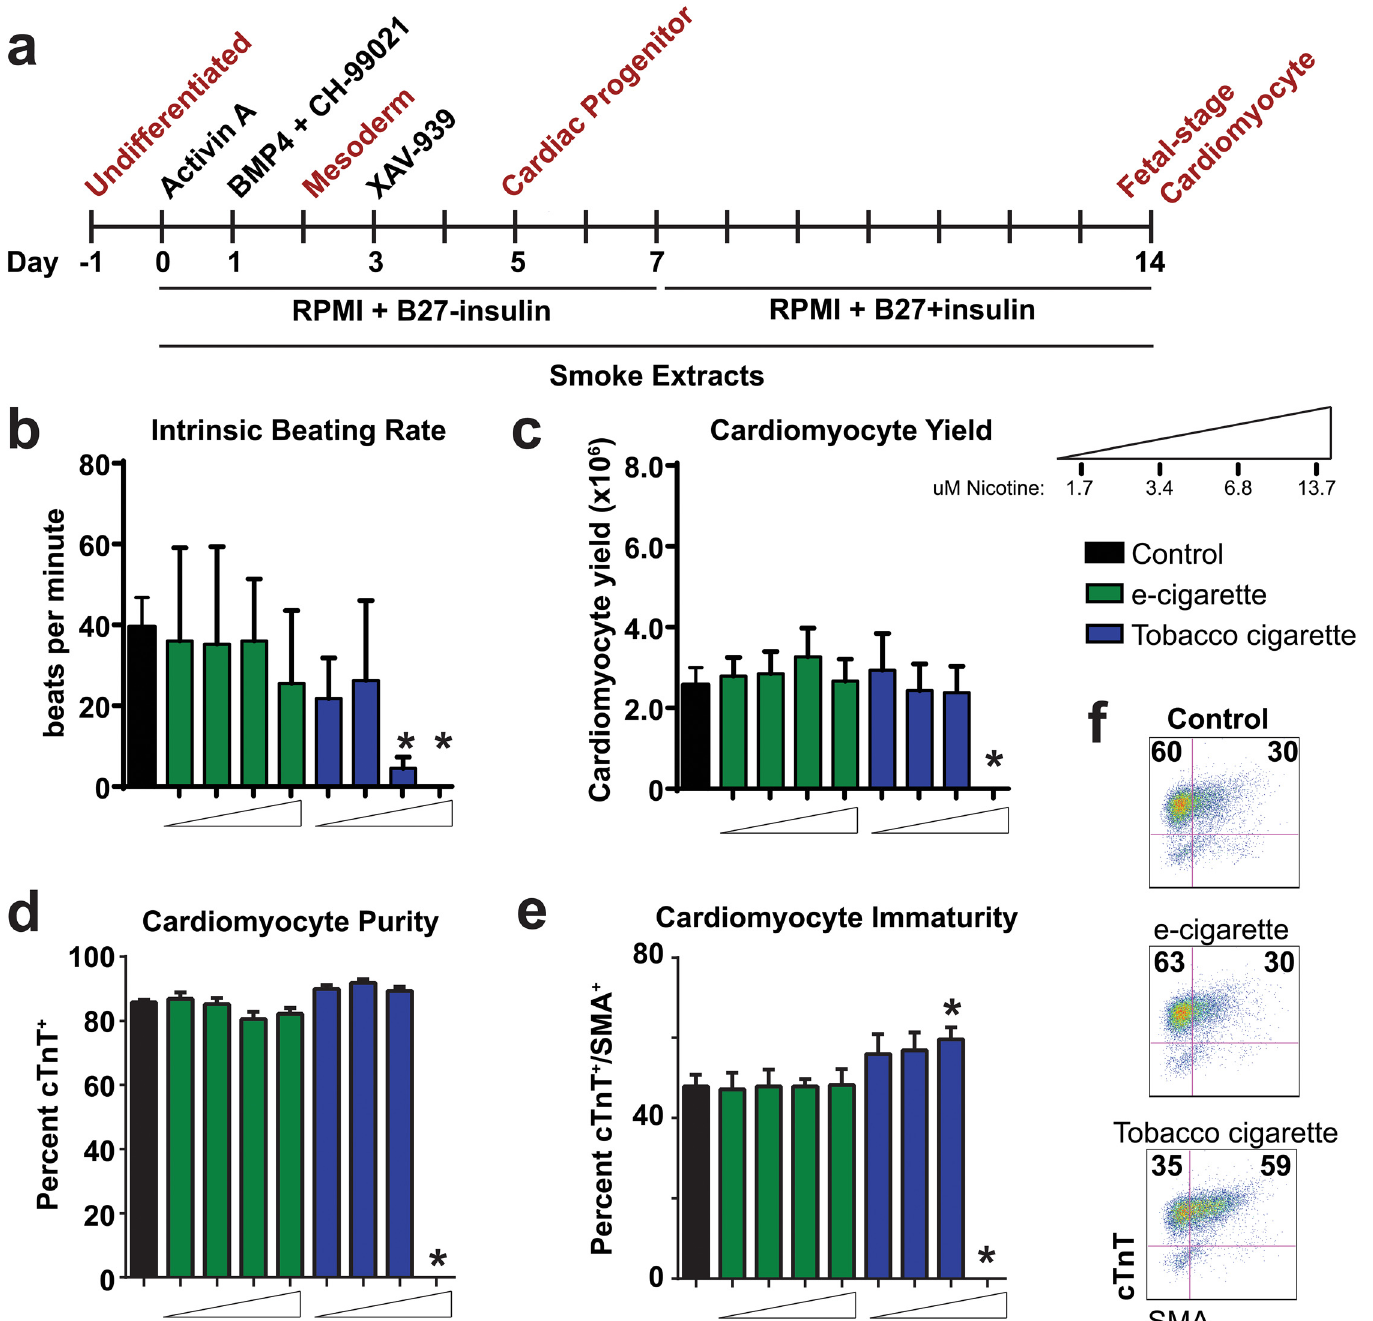
Fig 3. Analysis of e-cigarette and tobacco cigarette on hESC cardiac differentiation. (a) Timeline of differentiation protocol for cardiac directed differentiation of hESCs. (b-e) Analysis of cardiac endpoints including intrinsic beating rate (b) cardiomyocyte yield (c), cardiomyocyte purity (d), and cardiomyocyte immaturity based on percent cTnT + /SMA + (e) and representative flow cytometry plots (f) on day 14 of differentiation with increasing doses of purified e-cigarette and tobacco cigarette extracts. n (cid:3) 6 per group. * P < 0.05.